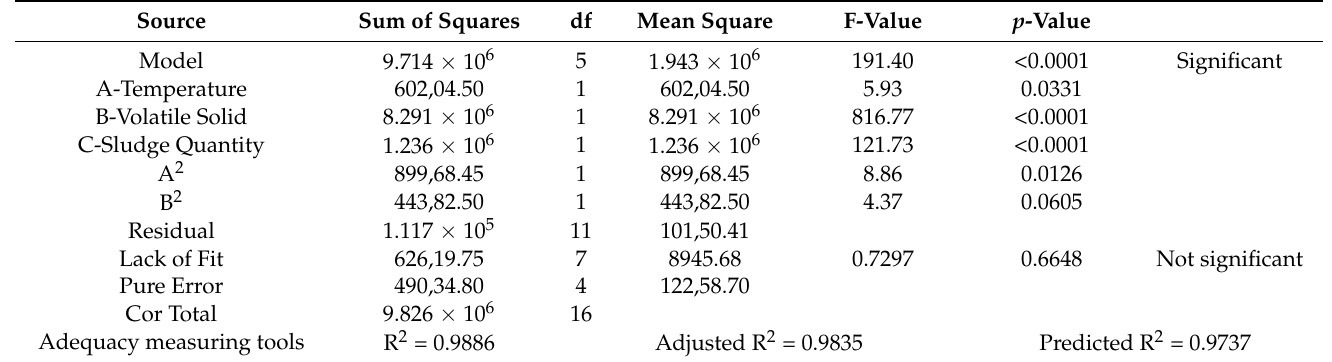
Table 5. ANOVA table for the Biogas Response.